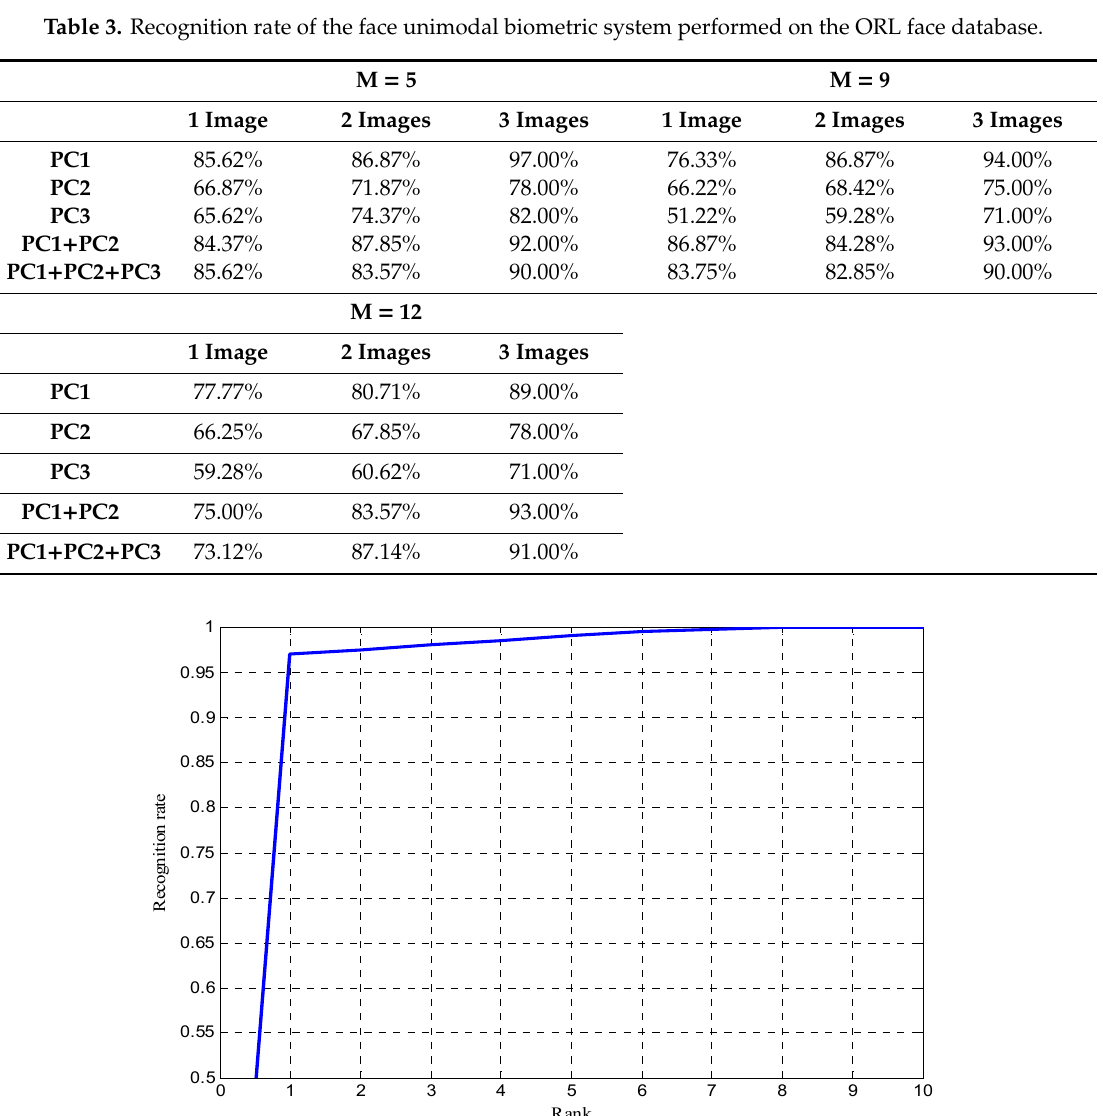
Figure 9. Cumulative match characteristic (CMC) curve for face unimodal biometric system performed on the Olivetti research laboratory (ORL) face database.